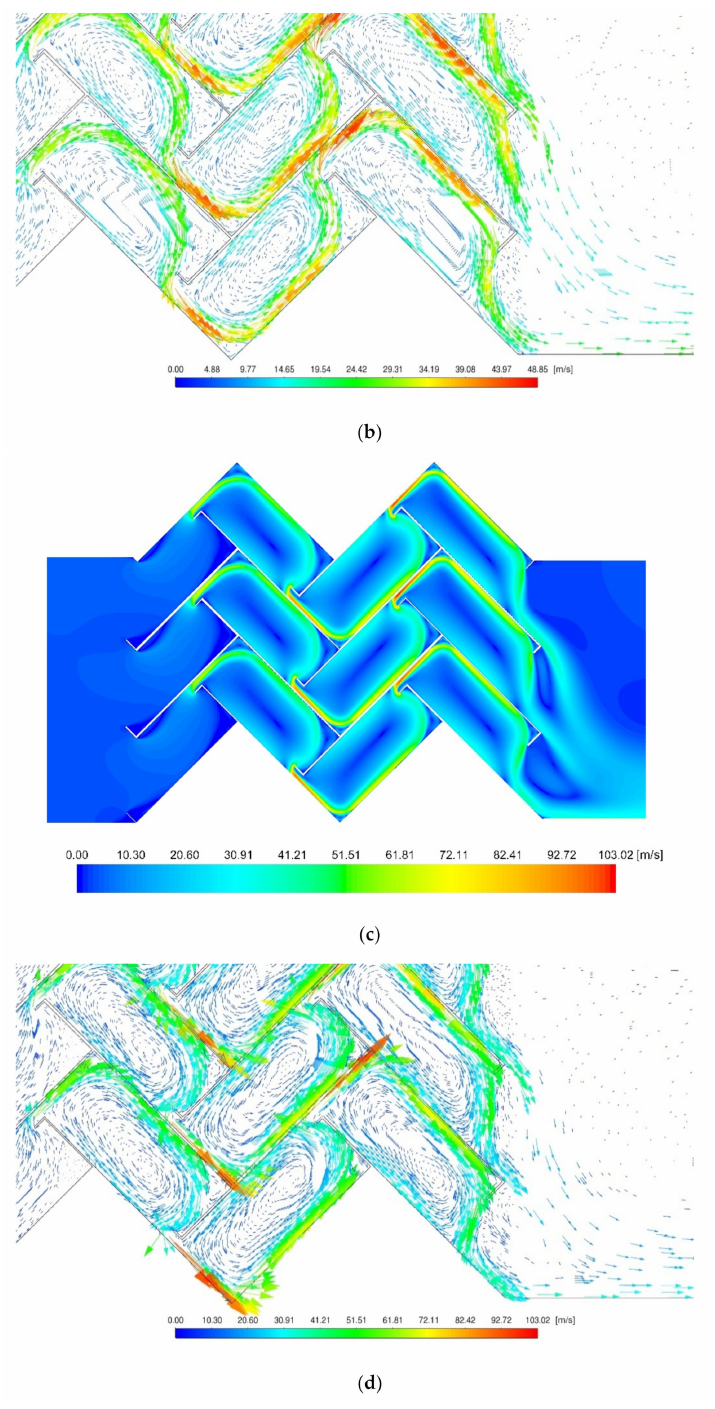
Figure 11. Velocity fields ( a , c ) (m s − 1 ) and vectors ( b , d ) and vectors (m s − 1 ) of investigated geometry variants with different drainage channel lengths: ( a , b ) B_25_0; ( c , d ) B_30_0; with inlet velocity 4 m s − 1 simulated using a transition SST